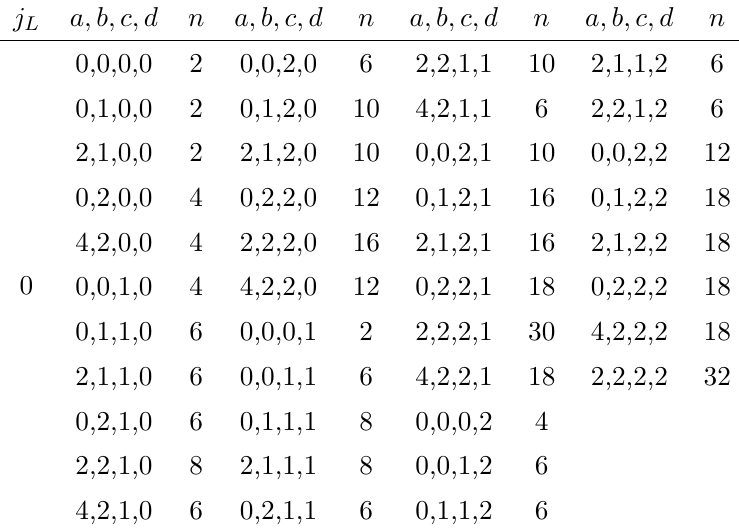
for SO(8) , k = 1 1 ,a,b,c,d